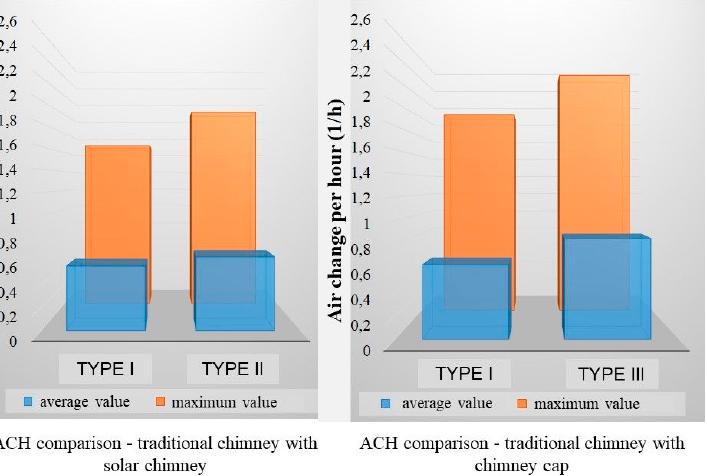
Figure 17. Summary of ACH results average value and maximum value for the three types of chimneys.